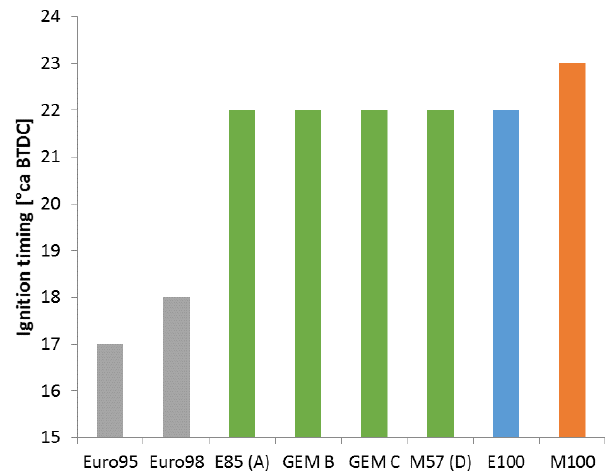
Figure 20. Knock-limited spark advance of all GEM blends and individual blend components. Audi-based single-cylinder research engine configured with a higher-than-standard CR of 13.1:1. Operating point of 25 Nm (BMEP = 7.71 bar) and 2000 rpm.